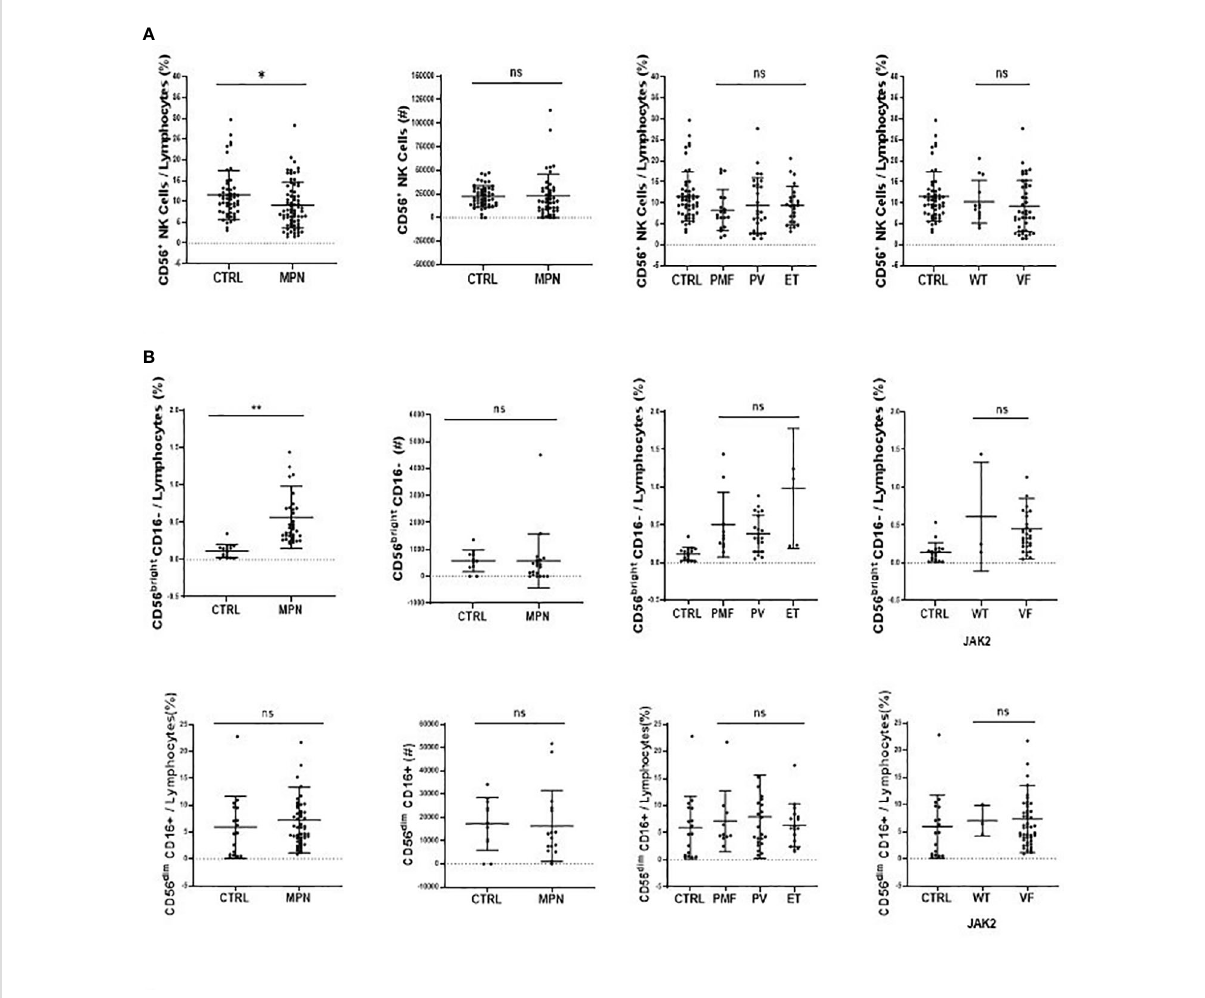
FIGURE 3 CD56bright CD16 − NK-cell subset is increased inMPN patients. The frequency and absolute number of (A) NK cells (CD45high, CD19 − , CD3 − , CD56 + ) and (B) classical NK function subsets (CD56brightCD16 − and CD56dimCD16 + ). CTRL, control (n = 17); MPN, myeloproliferative neoplasms (n = 49); PV, polycythemia vera (n = 22); ET, essential thrombocythemia (n = 5); PMF, primary myelo fi brosis (n = 10). Error bars indicate the mean (± SEM). NS, not signi fi cant (p > 0.05); *p < 0.05; **p < 0.01; Mann – Whitney and Kruskal – Wallis